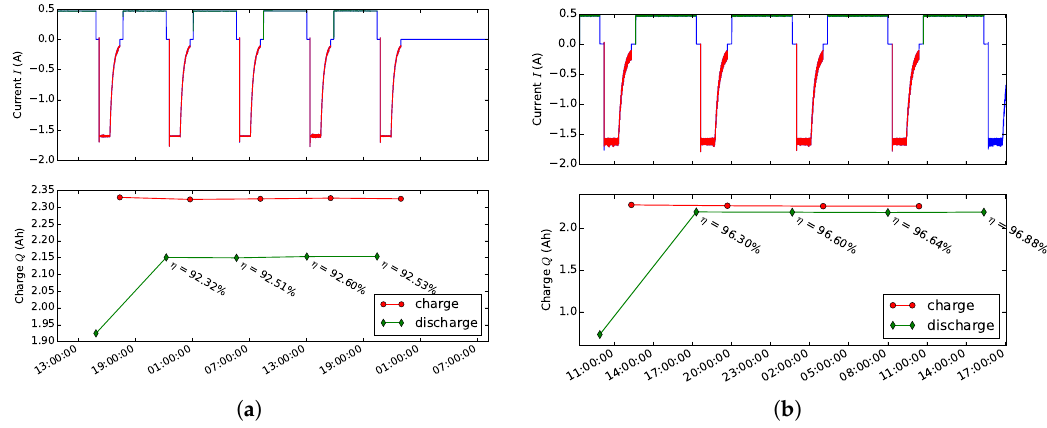
Figure 19. Comparison of cell balancing for a 3S1P ( a ) passive; ( b ) active.